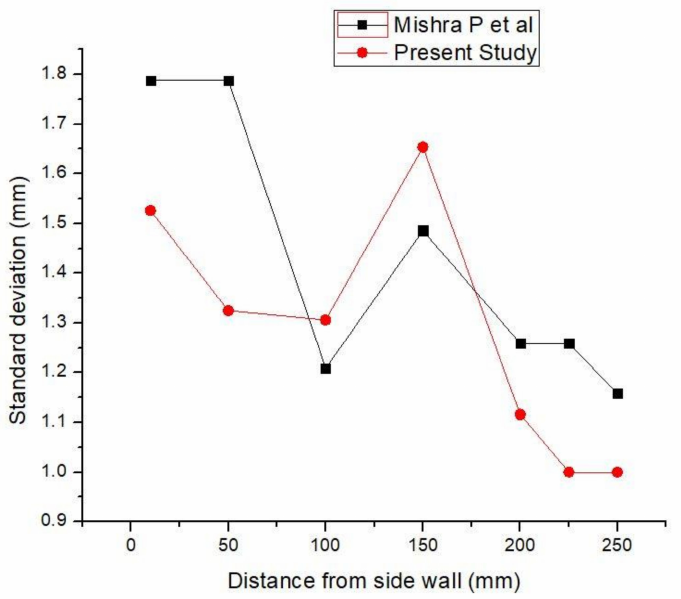
Figure 3. Comparison of the standard deviation of the meniscus along the mould width for 15 ◦ downward rectangular port nozzles with a different